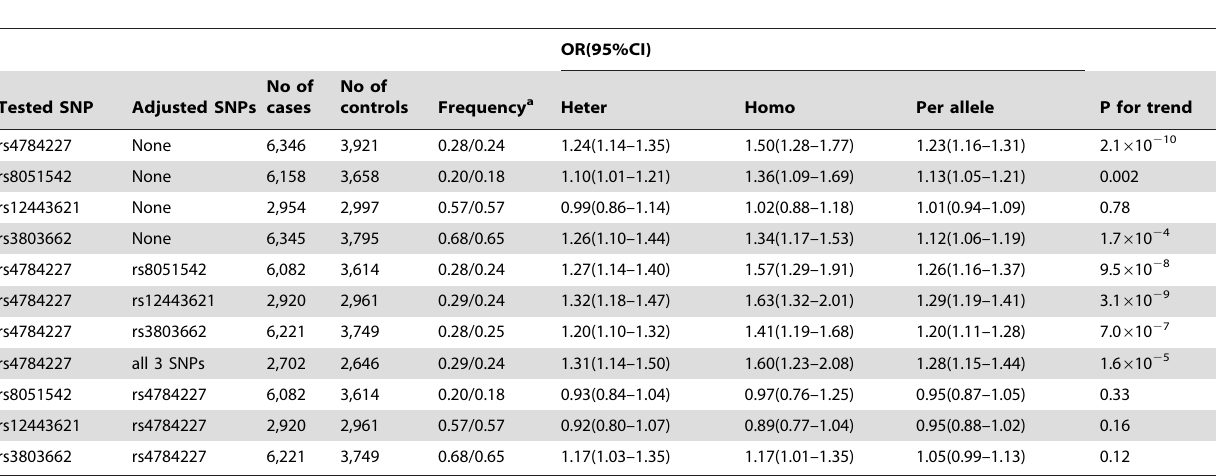
Table 4. Association of rs4784227 and the three previously-reported SNPs at 16q12with breast cancer risk among Chinese women in Stages I and II.